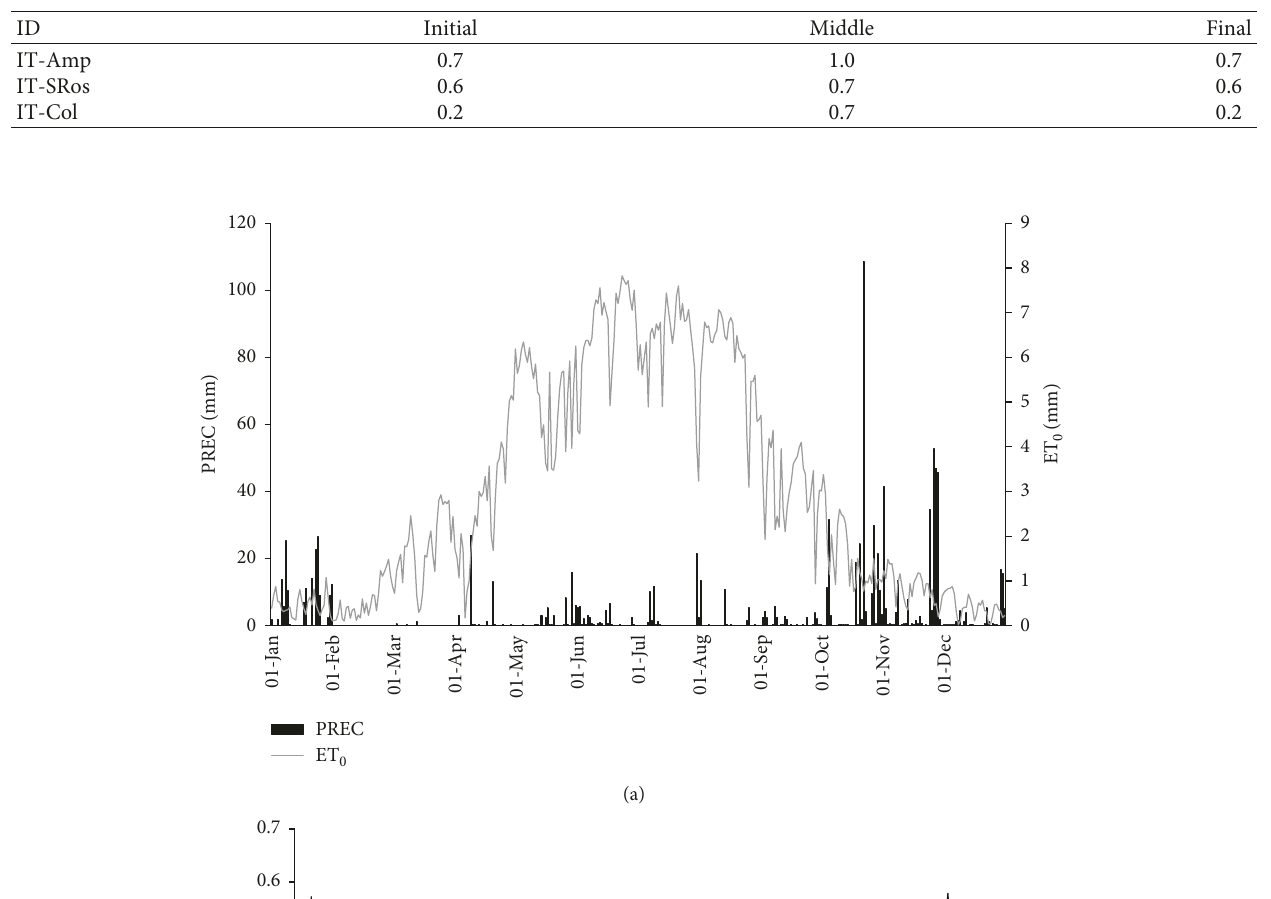
Table 2: Initial, middle, and final Kc values utilized in the three case